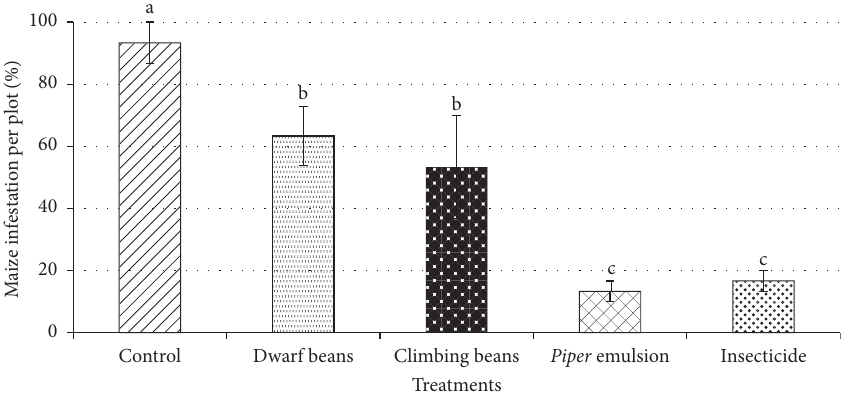
Figure 1: Effect of treatments on maize infestation (mean ± SD) by fall armyworm at seven weeks after planting. Values with different letters are significantly different ( P < 0 .